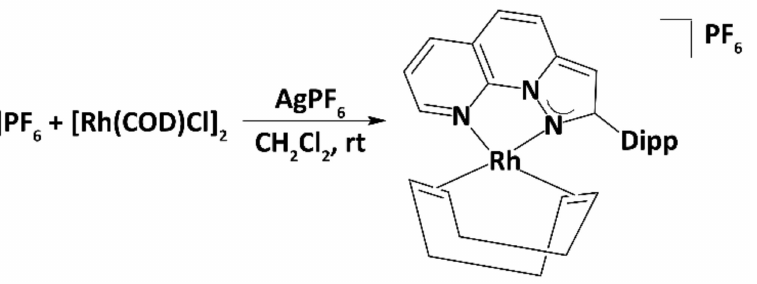
Scheme 6. Reaction scheme for the synthesis of Rh(I) complexes with a fused π